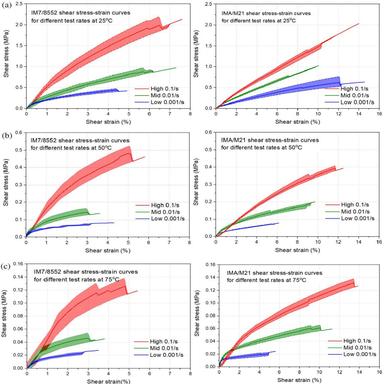
Influence of test rate on the measured shear stress versus shear strain curves (left - IM7/8552 and right - IMA/M21) at (a) 25 °C, (b) 50 °C and (c) 75 °C. (For interpretation of the references to colour in this figure legend, the reader is referred to the web version of this article.)